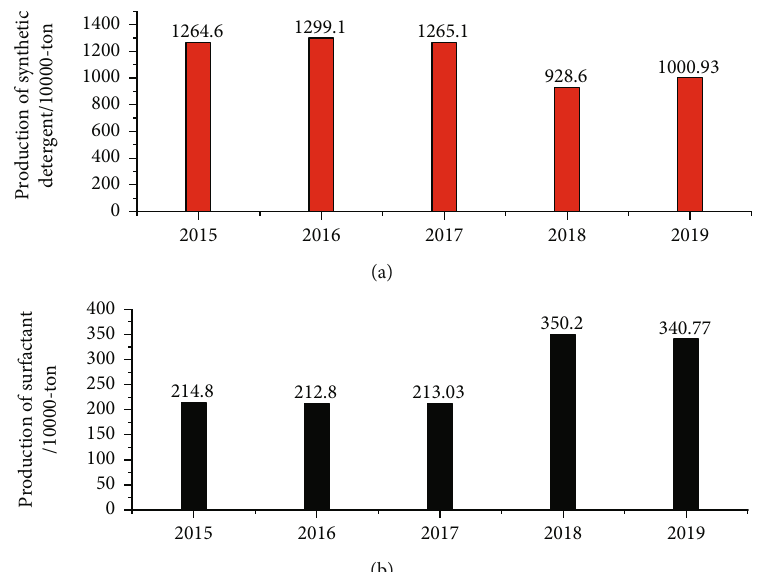
Figure 1: Production of synthetic detergents and surfactants in China: 2015 to 2019. Sources: (a) National Bureau of Statistics of China; (b) Surfactant Professional Committee of China Detergent Industry Association.